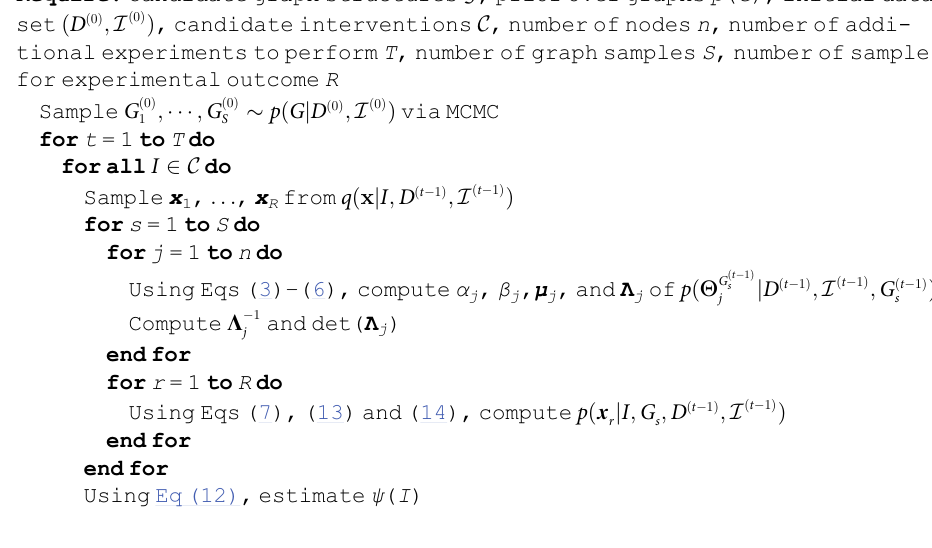
Algorithm 1 Active learning for